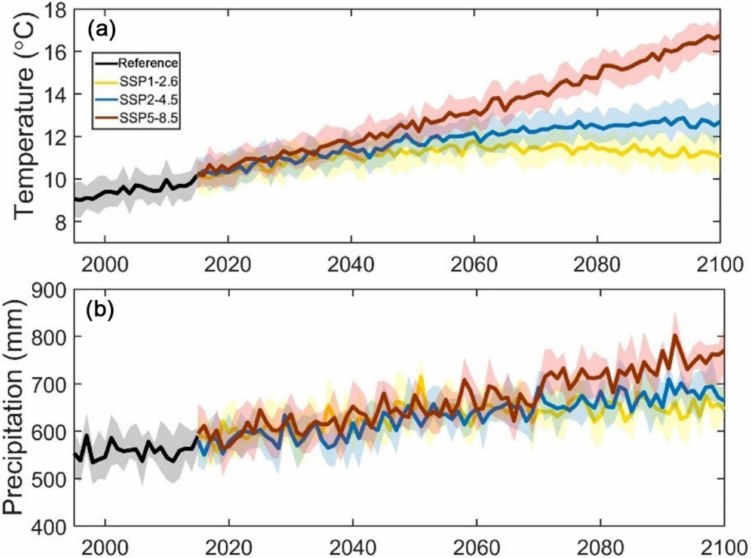
Figure 2. Variations and projections in ( a ) annual mean temperature and ( b ) annual total precipitation from 1995 to 2100 in China. Both annual mean temperature and annual total precipitation are detected to increase in China during 1995–2100, especially under SSP5 −